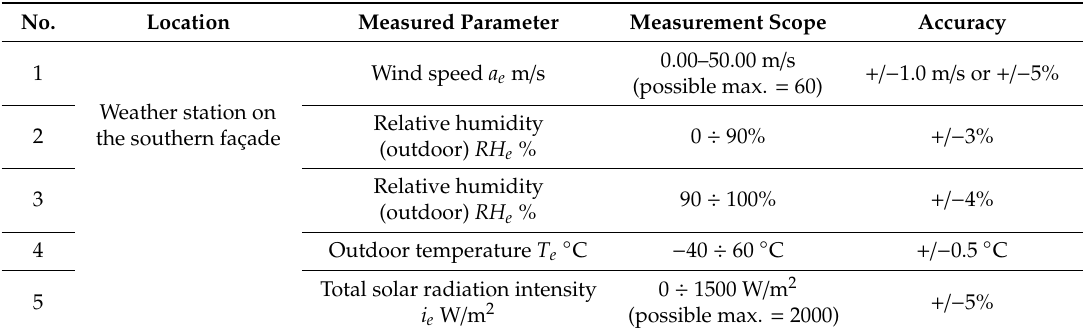
Table 3. Data of weather station sensors.